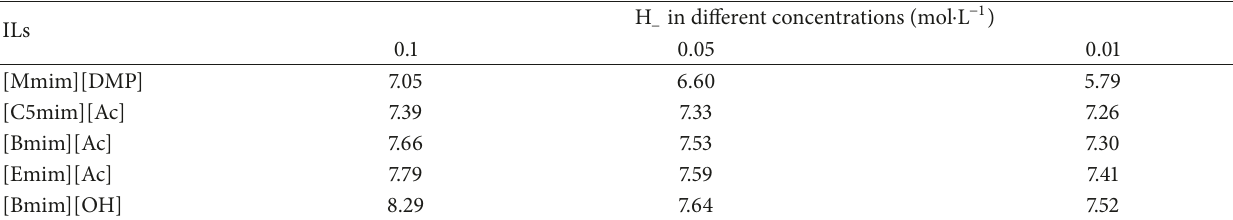
Table 1: H − values in different concentrations of alkaline ionic